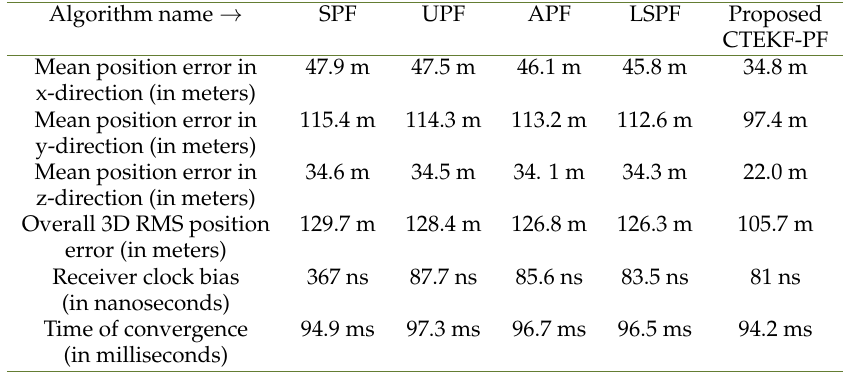
Table 1. Average estimation errors and time of